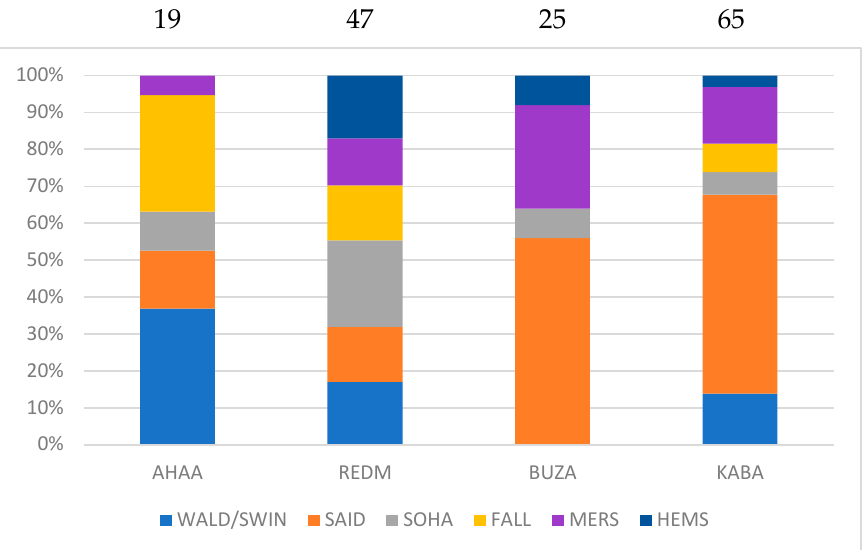
Figure 4. Type-2 connections between East Tropical African breeds and other breeds (around 70% of the total links were retained). The full data are presented in Supplementary Table S4. The values are given in percentages but the real sums are indicated at the top of each bar. The four-letter code of each breed is the same as in Table 1.